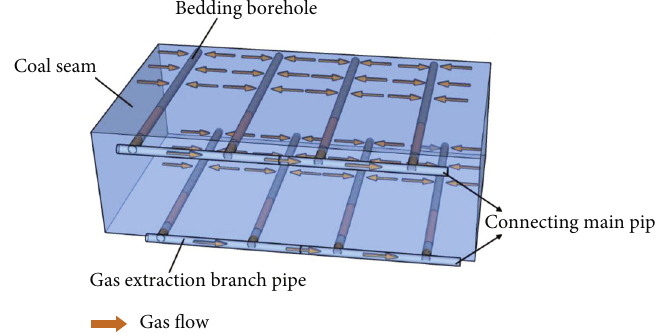
Figure 11: Illustration of dislocation bedding borehole in combined coal